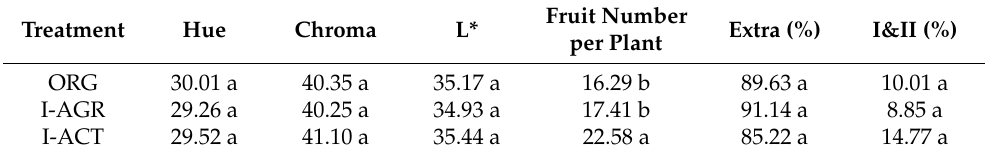
Table 2. Effects of cultivation management on fruit color parameters and category